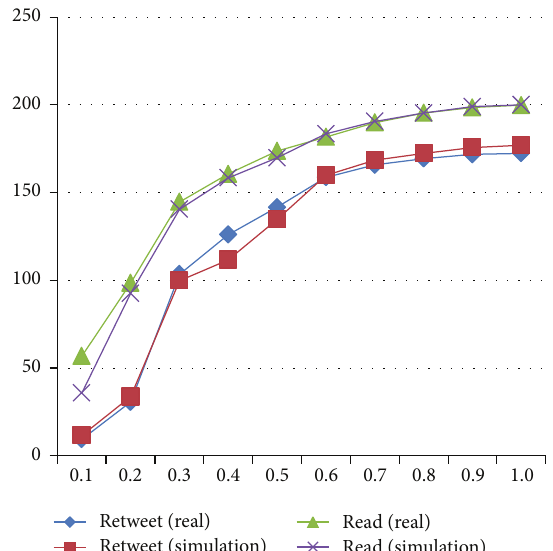
Figure 4: The relationship between the importance of knowledge content and